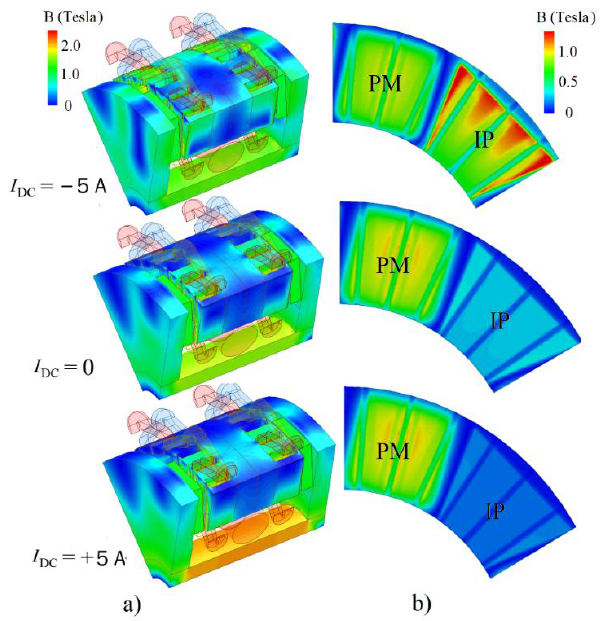
Figure 6. Magnetic flux density distribution on the 3-D FEA model ( a ) and in the middle of the air gap of the machine ( b ).